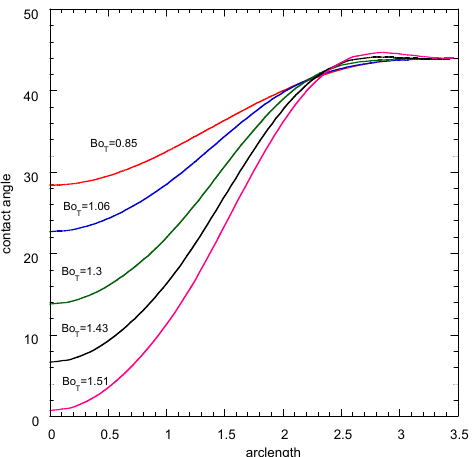
Figure 5. Evolution of contact angle distribution along the evolved contact line for an increasing tangential Bond number (linear Young–Laplace equation, V = 0.6).